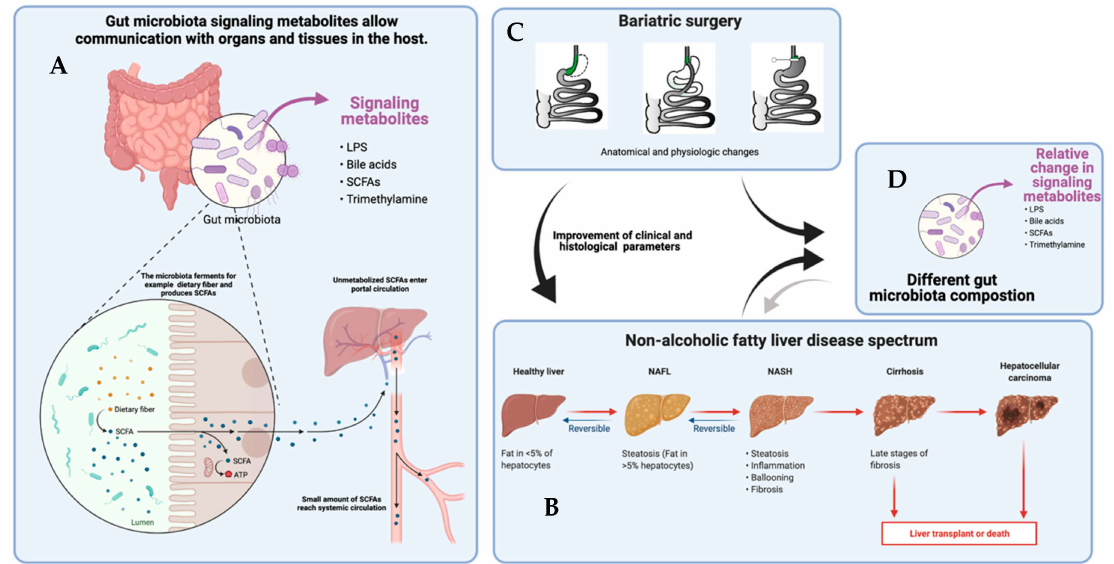
Figure 1. Overview of the gut microbiome and metabolites, and relationship with NAFLD and bariatric surgery. ( A ) A systematic overview of how gut microbiota contribute to producing metabolites such as LPS, bile acids, SCFAs and trimethylamine. The metabolites enter the portal circulation, where they are further metabolized and enter the systemic circulation. ( B ) The spectrum of non-alcoholic fatty liver disease. The black arrow indicates that the different stages of NAFLD are associated with a different composition of gut microbiome and plasma metabolites. The smaller grey arrow indicates the possible relationship of gut microbiome composition and plasma metabolites on non-alcoholic fatty liver disease; however, this causal role remains to be verified. ( C ) Three types of bariatric interventions are displayed: sleeve gastrectomy, Roux-en-Y gastric bypass, and vertical gastric banding. Bariatric surgery is associated with changes in gut microbiome composition and altered metabolite levels. Bariatric surgery is also associated with improvements of fatty liver disease. ( D ) Different gut microbiota compositions and relative changes in metabolites are observed in individuals with NAFLD and after bariatric surgery compared to (lean and/or pre-operative) controls. Evidence points toward a causal role for microbiome and metabolites in the pathophysiology of fatty liver disease and improvement after bariatric surgery; however, this remains to be verified. LPS, lipopolysaccharides; SCFAs, short-chain fatty acids; ATP, adenosine triphosphate; NAFLD, non-alcoholic fatty liver disease; NASH, non-alcoholic